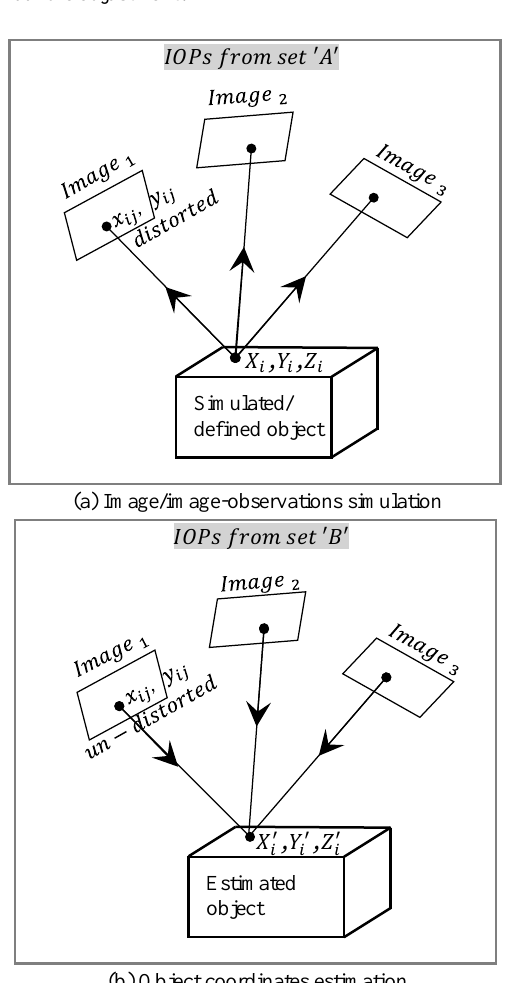
Figure 1. Stability analysis of a single